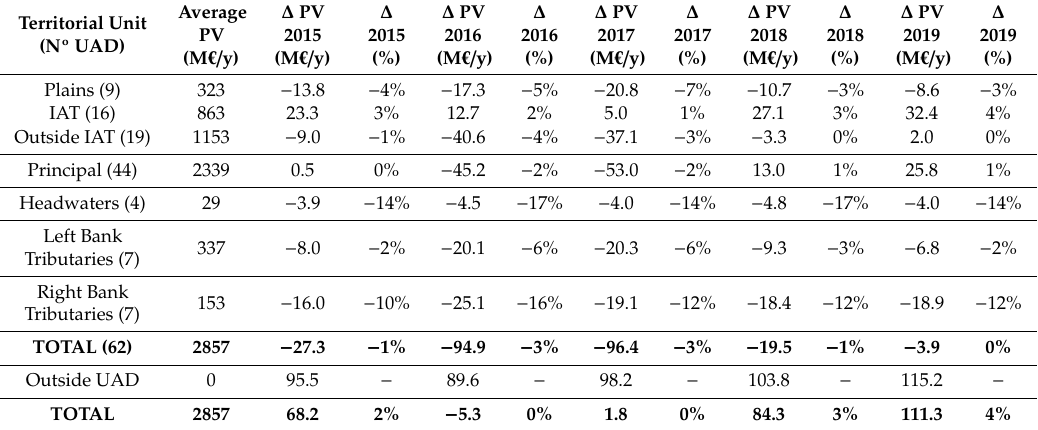
Table 11. Comparison of the production value (PV) with respect to the average of the SBHP 2015 / 21. Source: HPO. Own